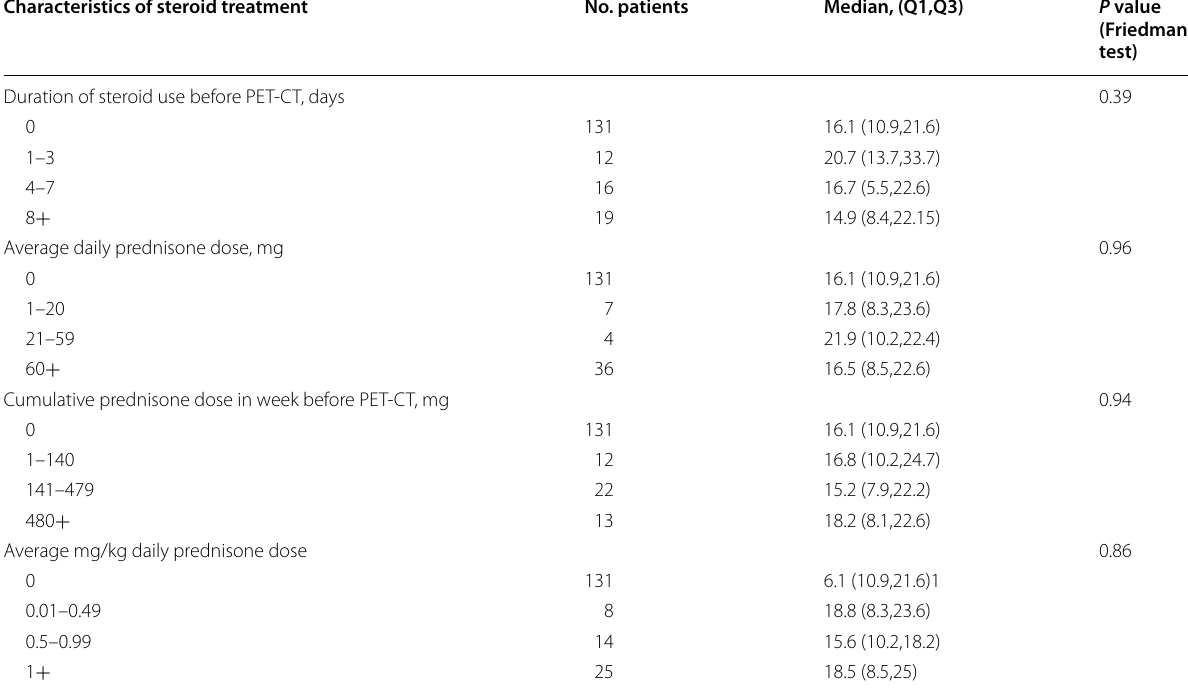
PET-CT positron emission tomography computed tomography